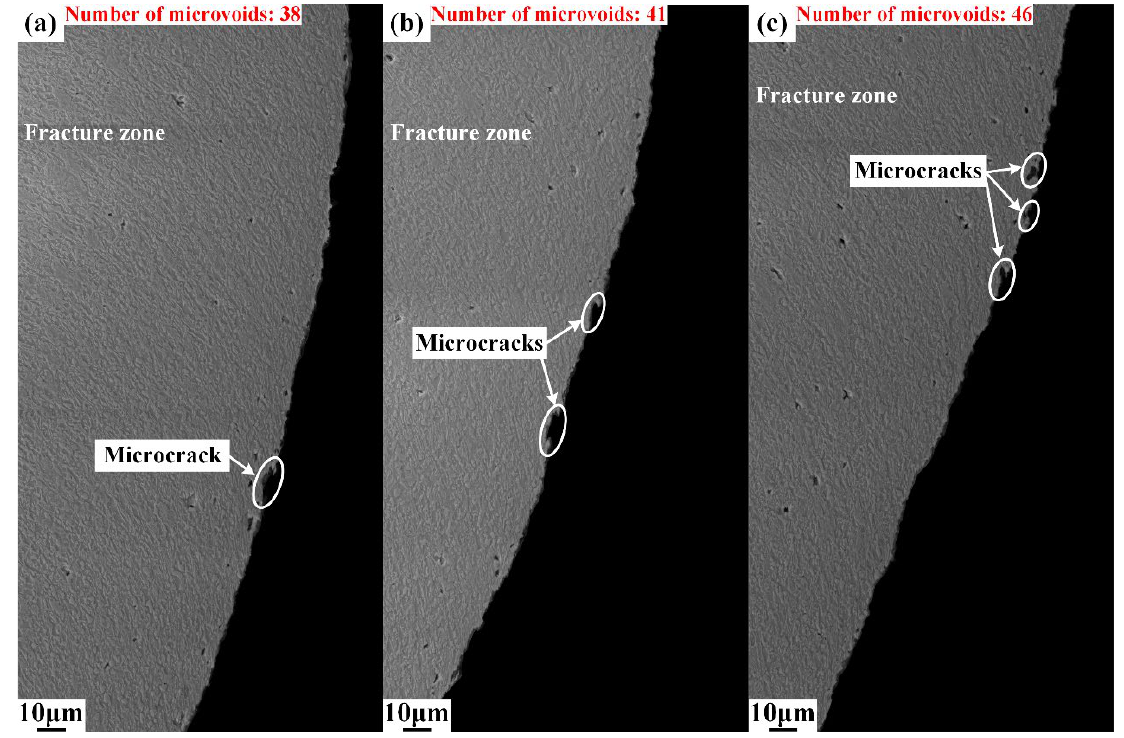
Figure 12. Microstructure of sheared edge in area IV obtained under different shearing clearances: